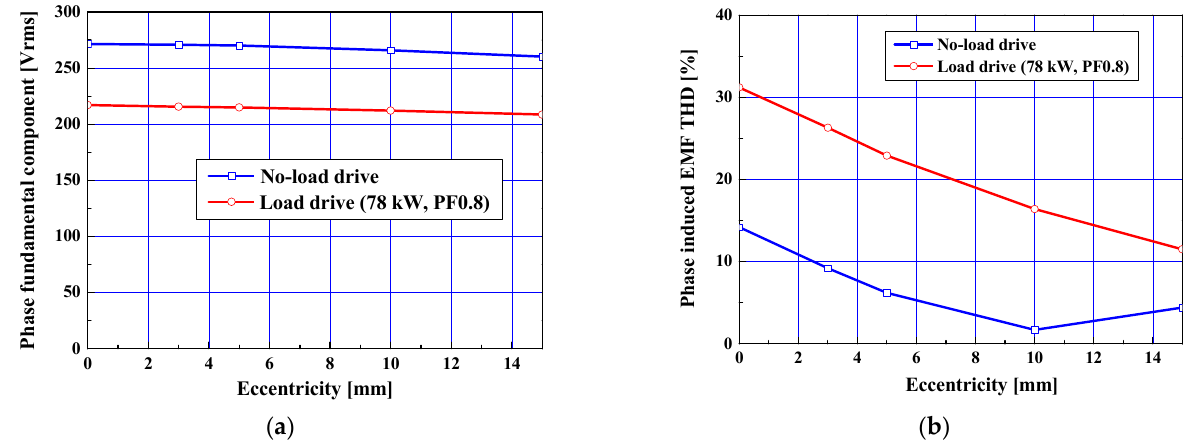
Figure 7. Induced EMF at no-load and load drives according to the eccentricity: ( a ) fundamental component, and ( b ) THD. The change rate means the percentage of the induced EMF for the two eccentricities was 0 and 15 mm. Accordingly, the change rates for the induced EMF were relatively small according to the eccentricity. In case of the induced EMF THD at the no-load and load drives, the induced EMF THD decreased as the eccentricity increased. However, in the case of the no-load drive, the THD had a minimum value at the eccentricity of 10 mm and then increased again. Second, the other proposed design was a hybrid model, an eccentric shape including the slit shape of Figure 5b. Figures 8 and 9 show the wave form and THD for the proposed model at the no-load and load drives. The wave forms in Figure 8 were obtained by 2D FEA. These figures correspond to Figures 6 and 7, respectively. When applying the slit design, the eccentricity increased, and the wave forms of the induced EMF at the no-load and load drives moved closer to a sinusoidal wave form in a similar way to Figure 6.